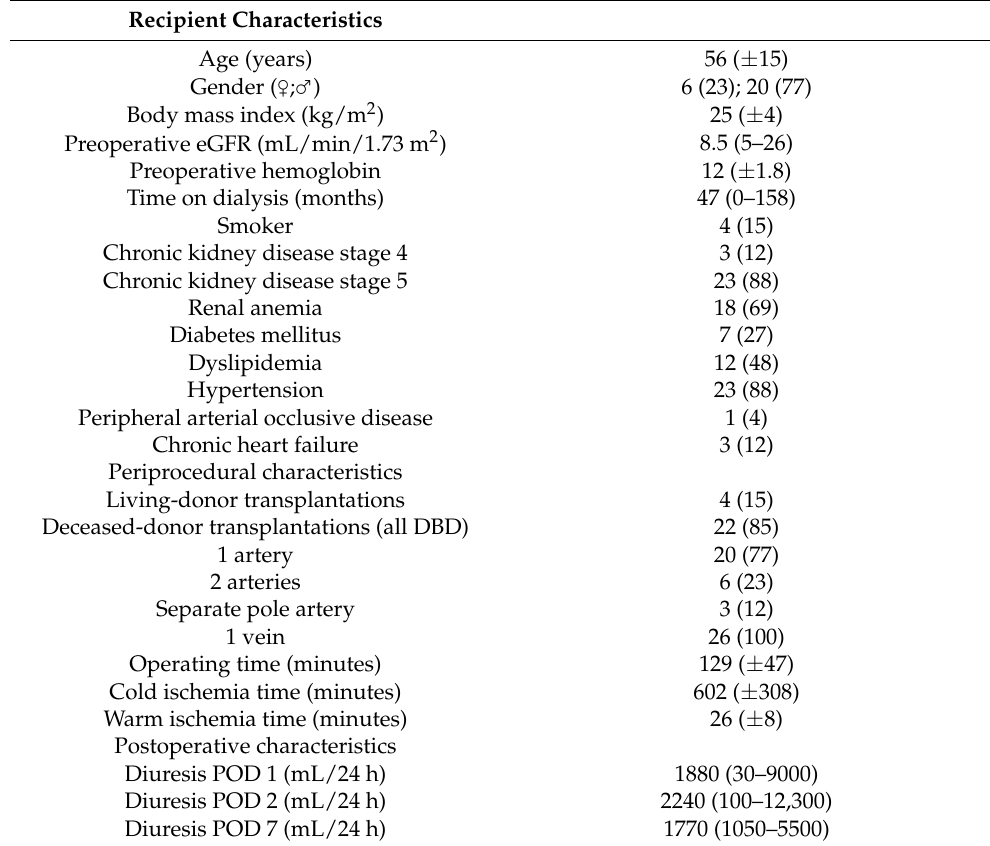
Table 1. Patient and periprocedural characteristics ( n = 26). Continuous variables are expressed as a mean and standard deviation or as the median with minimum and maximum. For categorical variables, absolute (numbers) and relative (percentage) frequencies are given.